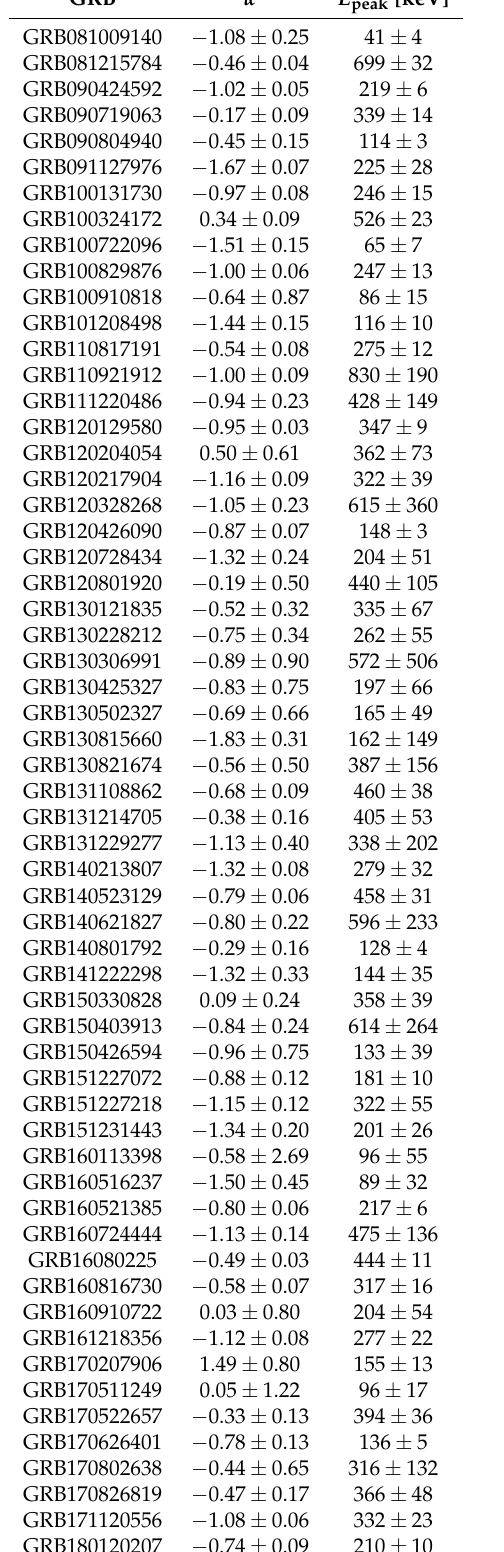
Table 3. Spectral parameters of the initial 2 s of long